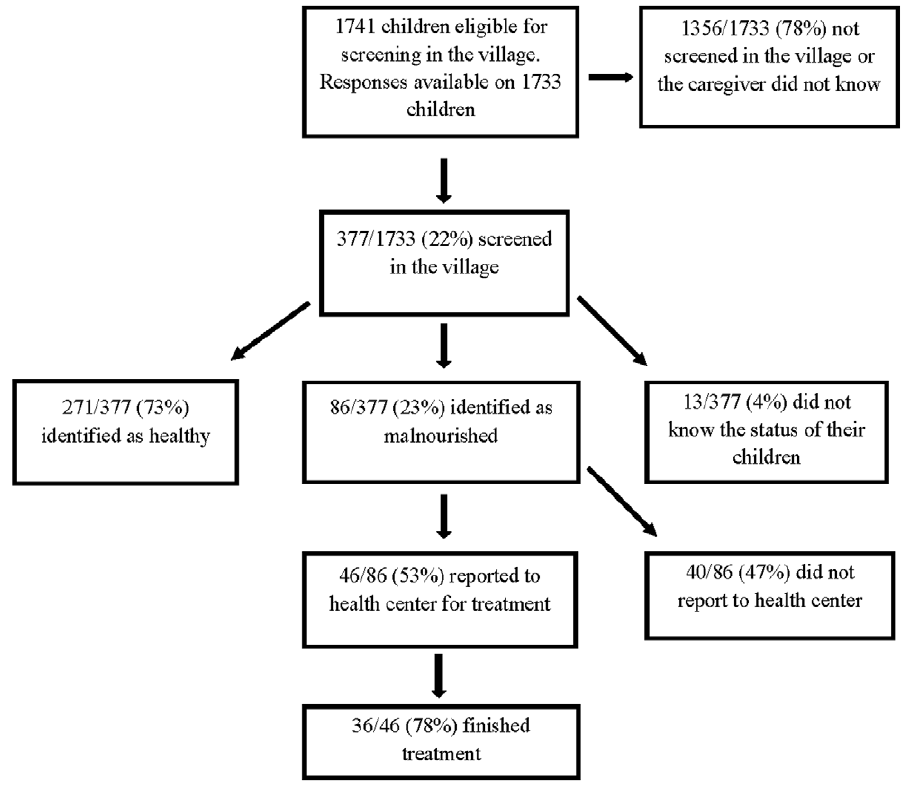
Figure 2. Village screening.